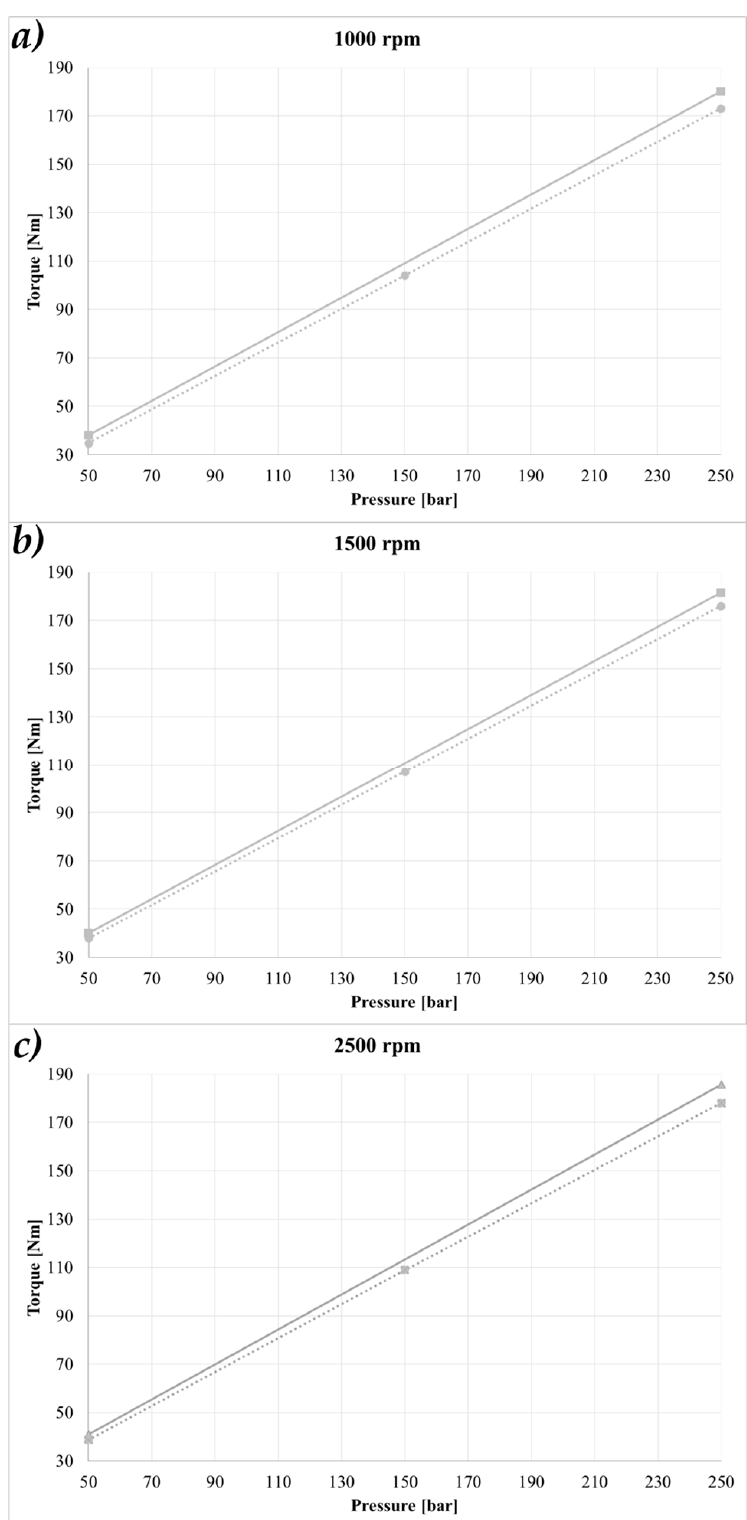
Figure 11. Absorbed torque—comparison between model and experimental data. ( a ) 1000 rpm; ( b ) 1500 rpm and ( c ) 2500 rpm.